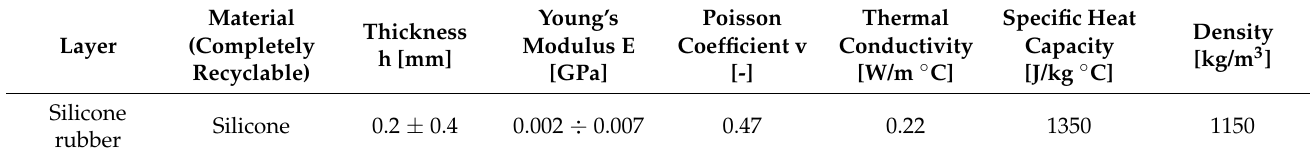
Table 9. Silicone rubber physical and mechanical characteristics.